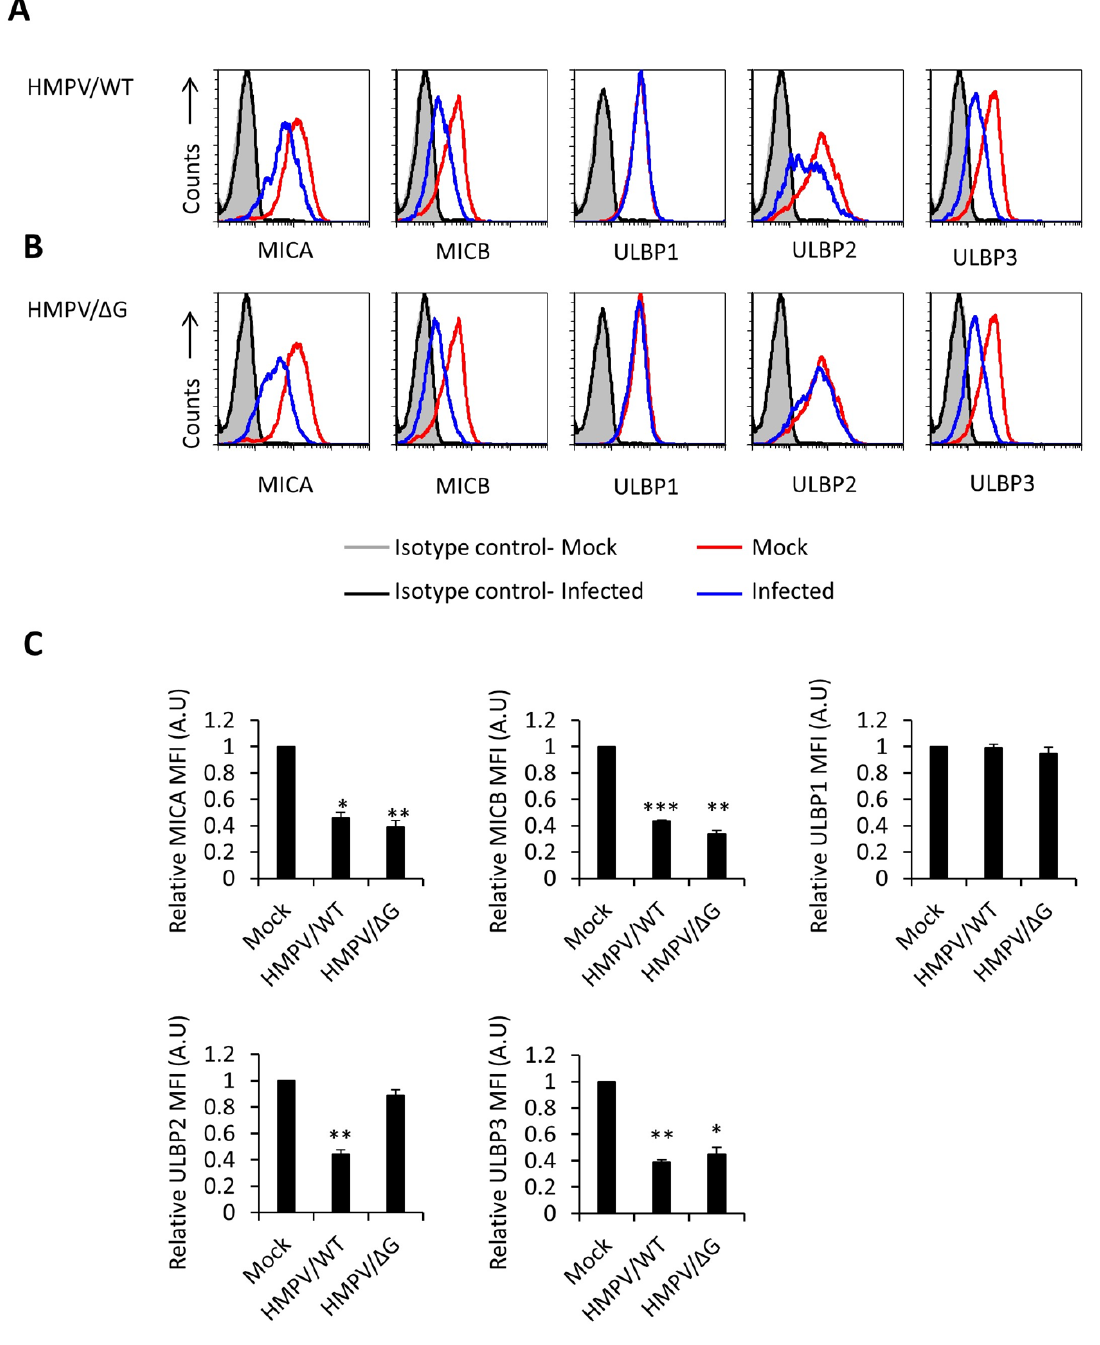
Figure 1. Infection of A549 cells with human metapneumovirus (HMPV) decreases the expression of NKG2D ligands. ( A and B ) Fluorescence-activated cell sorting (FACS) analysis of NKG2D ligands’ expression on the mock-infected A549 cells (empty red histogram) and on HMPV/Wilde Type (WT) ( A ) or HMPV/∆G ( B )-infected A549 cells (empty blue histogram) at 24-h post-infection. The filled gray histogram and the empty black histogram represent the staining of the mock-infected and infected A549 cells with a control antibody, respectively. ( C ) Quantification of the expression of NKG2D ligands on mock-infected, HMPV / WT, and HMPV / ∆ G-infected cells. Shown is the mean fluorescence intensity (MFI) of stress-induced ligands on the infected cells relative to mock-infected cells (set as 1) from five independent experiments combined. Statistical analysis performed using one-way ANOVA ( n = 5). p values were estimated using a post-hoc test. (*** p < 0.0001, ** p < 0.005, * p <